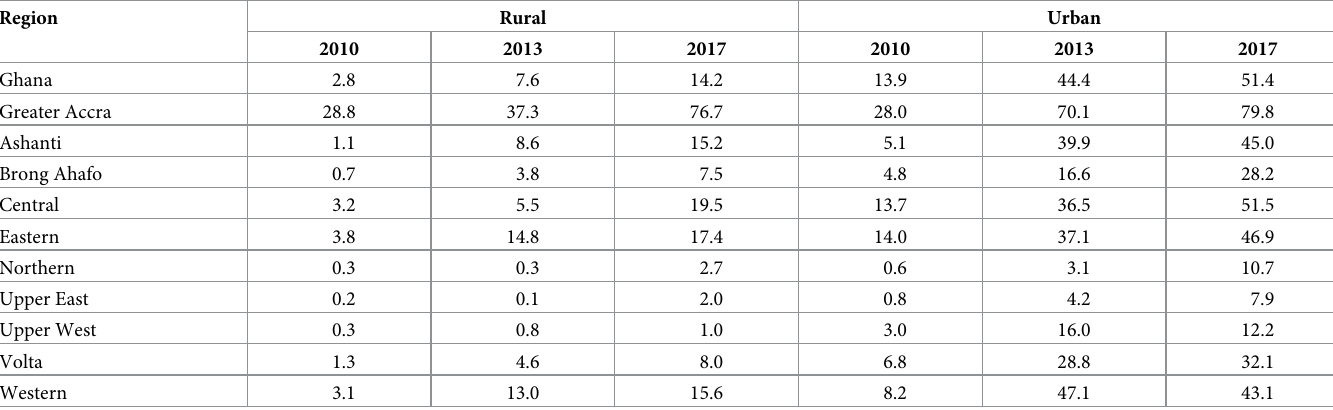
Table 6. Sachet water use among households by